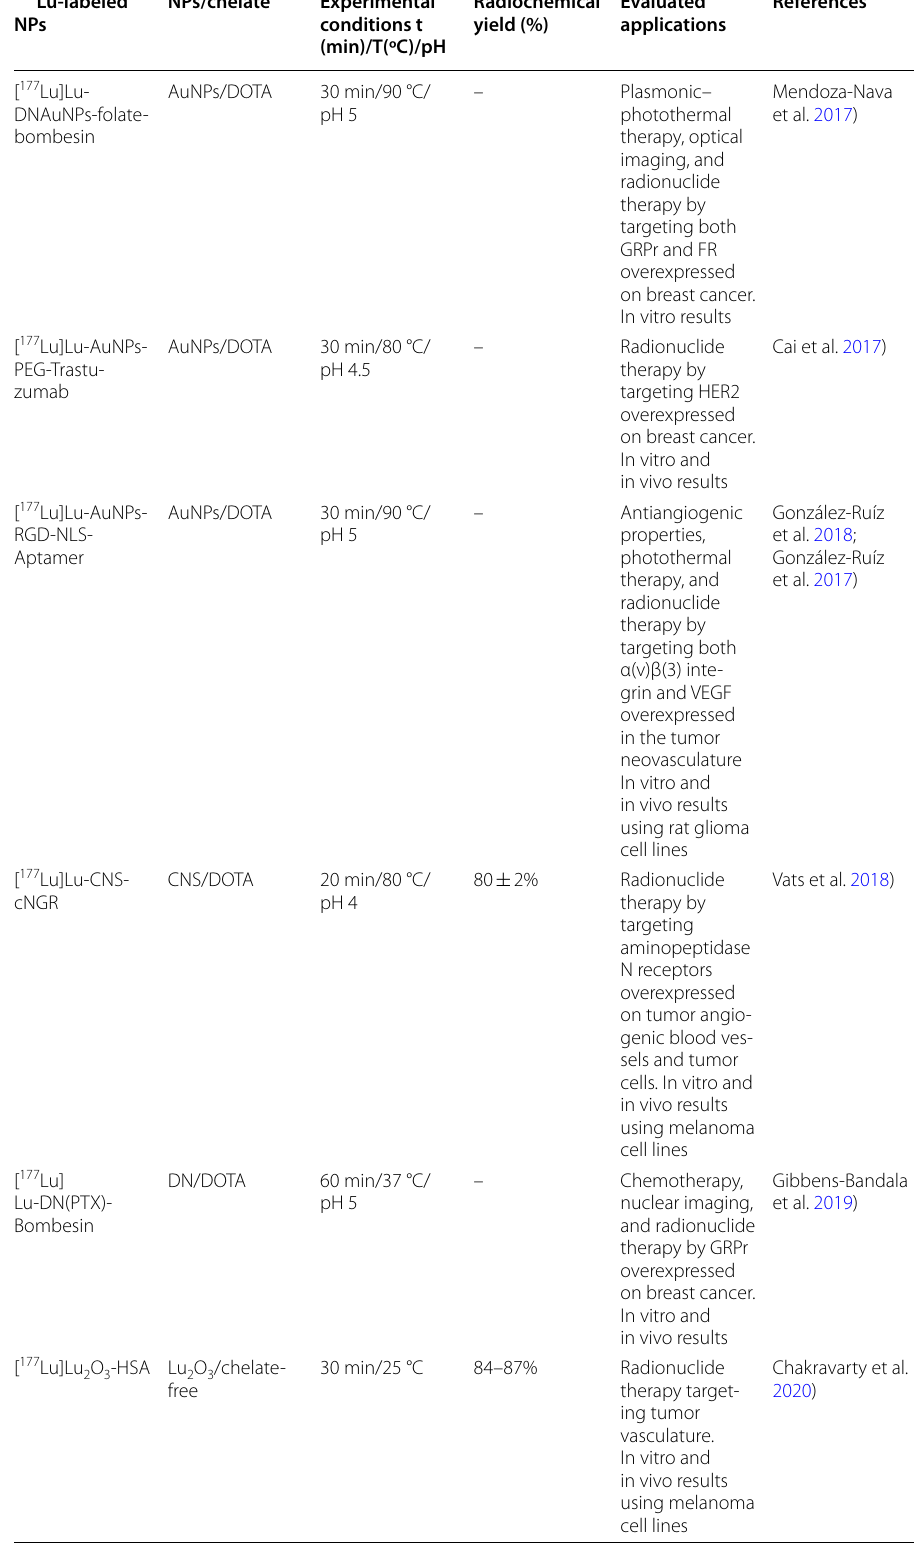
Table 4 Representative studies evaluating 177 Lu‑labeled nanoparticles in preclinical cancer models 177